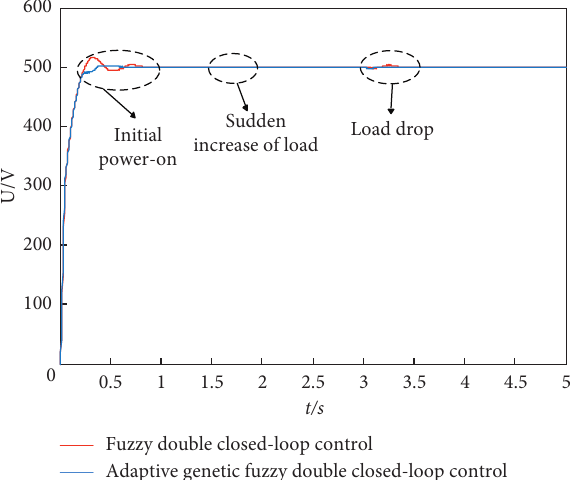
Figure 13: Microgrid 1 bus voltage